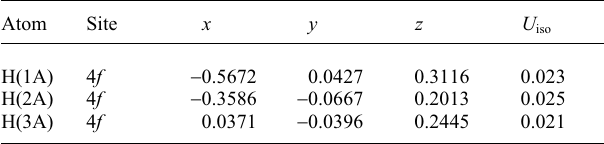
Table 2. Atomic coordinates and displacement parameters (in Å 2 )